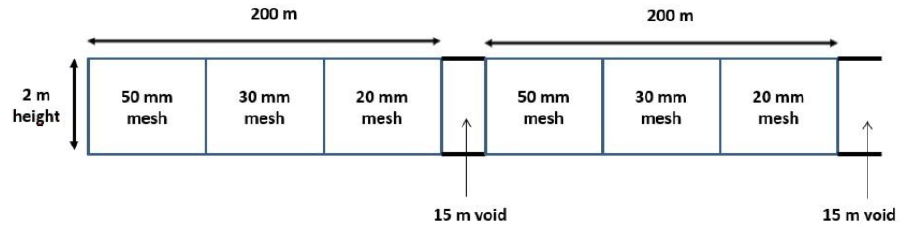
Figure 4. Fixed sampling net (barracuda) used for fish fauna sampling at the two sites. The scheme shows the arrangement of 2 sections out of 4 of a single net.